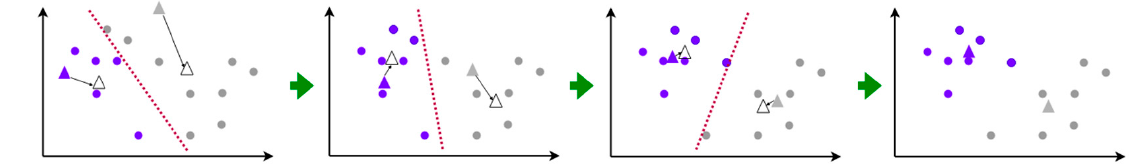
Figure 5. Visualization of the k-means method.